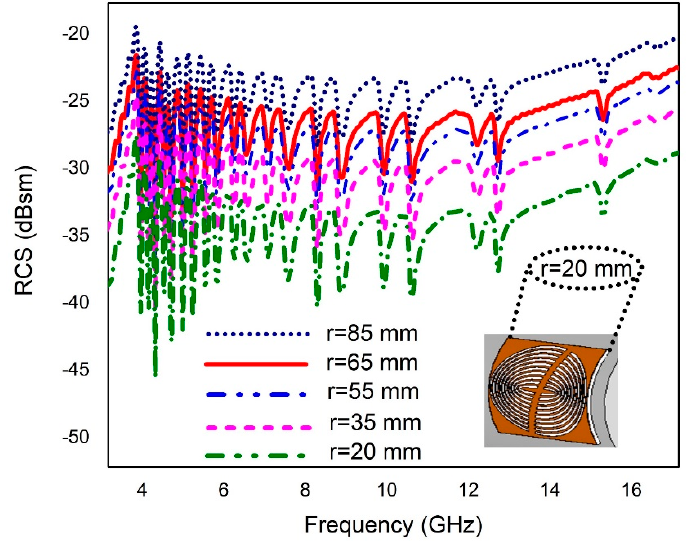
Figure 13. Bending analysis of the proposed tag.